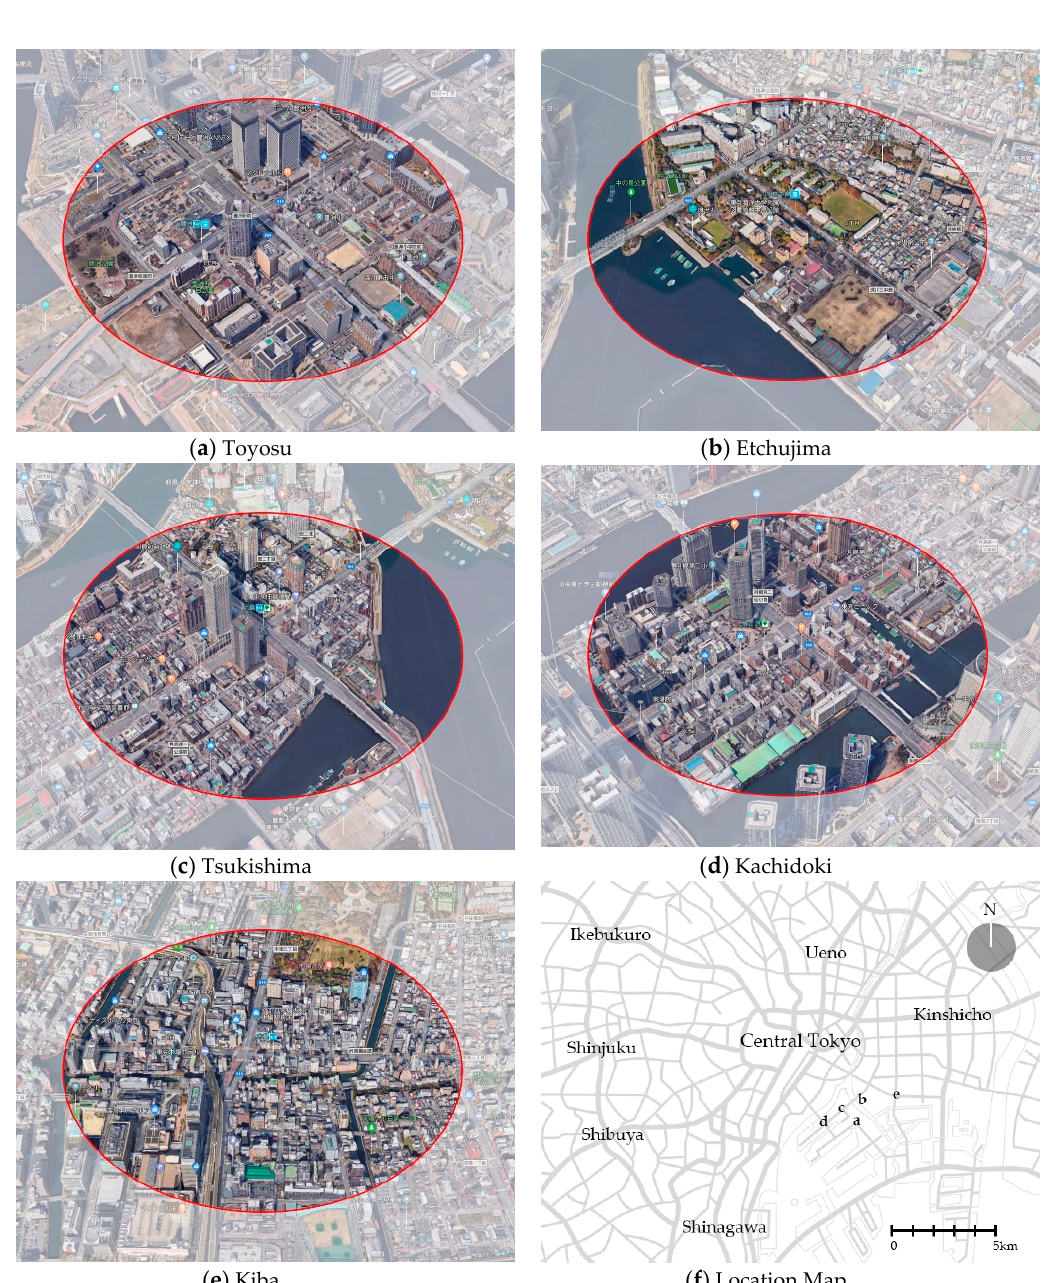
Figure 1. An overview of the study area [83–87] and its geographic location in Tokyo City. Table 4. Estimated total gross floor space of Toyosu, Etchujima, Tsukishima, Kachidoki, and Kiba station areas.